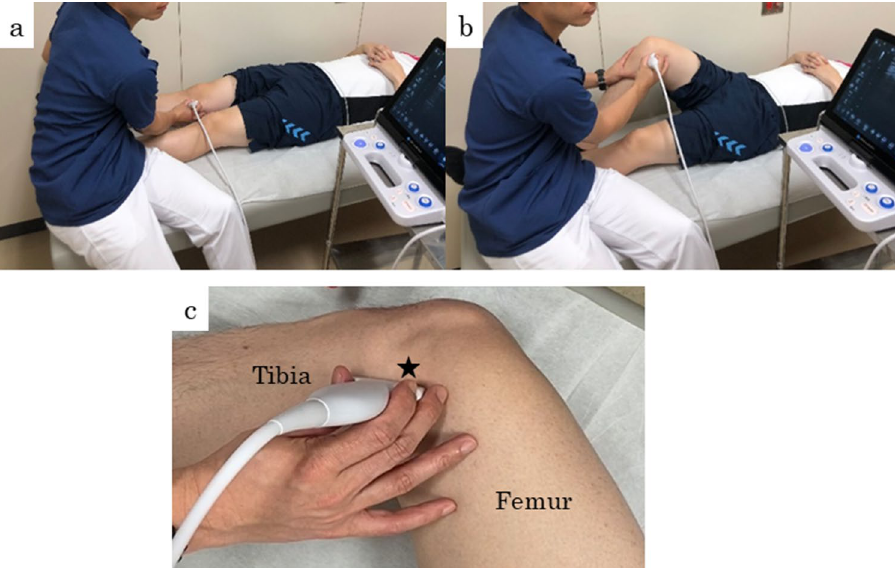
Figure 4. Ultrasonographic evaluations in the supine position at knee flexion angles of ( a ) 0° and ( b ) 90°. The appropriate probe position during MME evaluation ( c ). The femoral medial epicondyle was designated as a bony landmark (asterisk), and the proximal part of the probe was installed just behind it. MME medial meniscal extrusion.